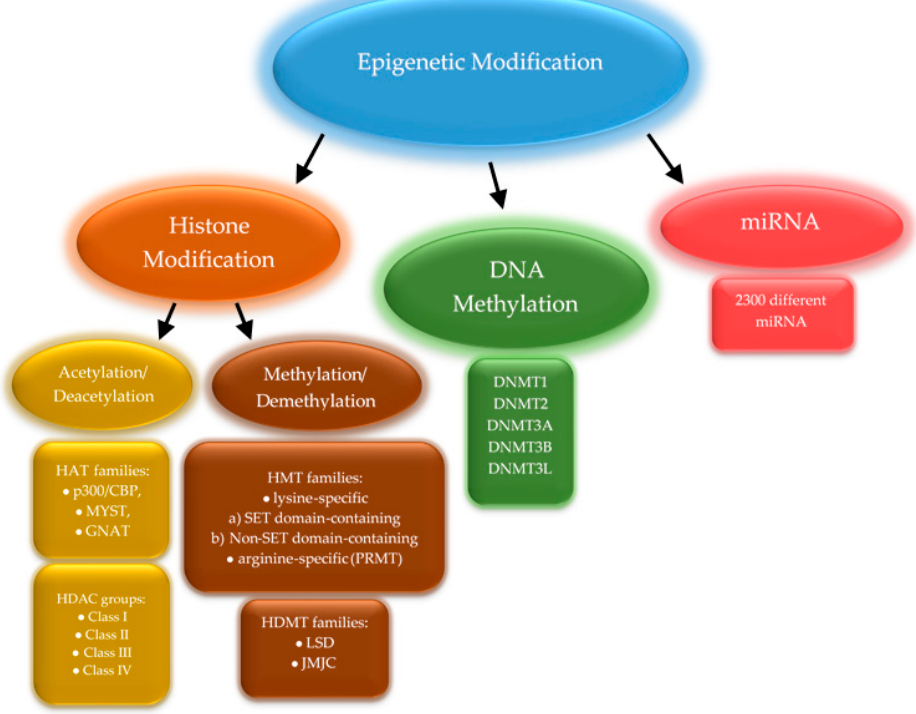
Figure 2. Three major epigenetic modifications. Enzymes classified into several families are responsible for the modification of histones proteins. The human DNA methyltransferase family consists of five members. The miRNAs are a diverse group of molecules with approximately 2300 different miRNAs [7].